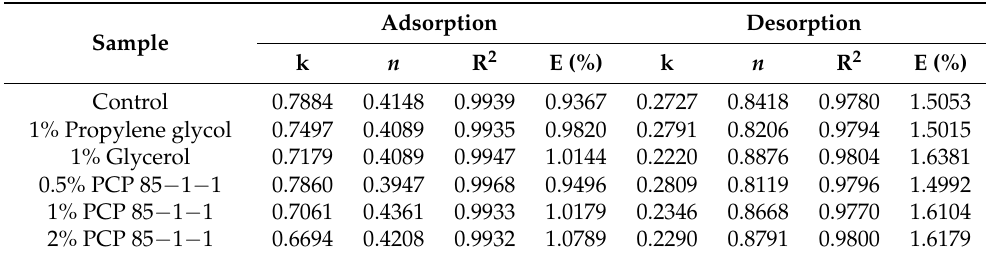
Table 2. Estimated Page model parameters and fitting criteria of tobacco shred samples with different humectants in adsorption and desorption